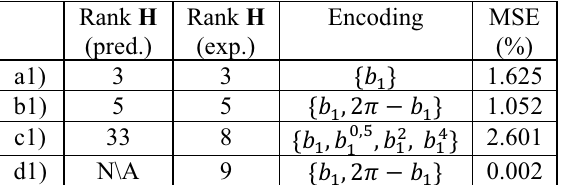
Table 1. Summary of the results from figure 2. The encoding variables (& (cid:17) , & (cid:28) ) is a one-to-one mapping of the (*, ") coordinates of each point to a linear amplitude modulation of the wavefront in distinct regions of the DMD screen.